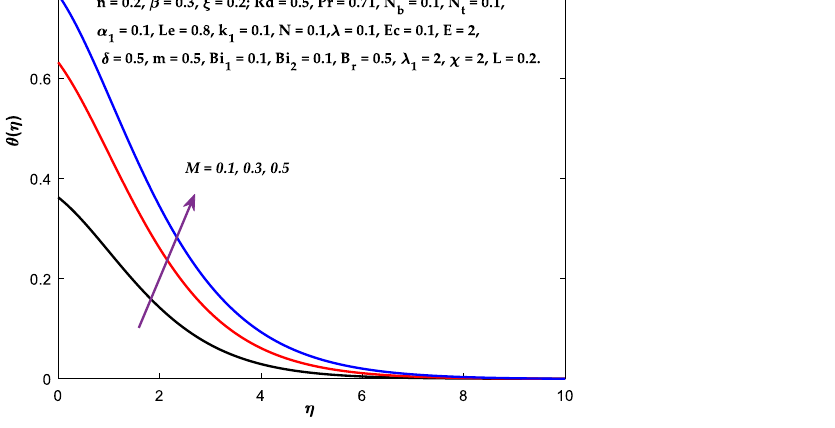
Figure 4. Diagram of M v/s θ(η) .